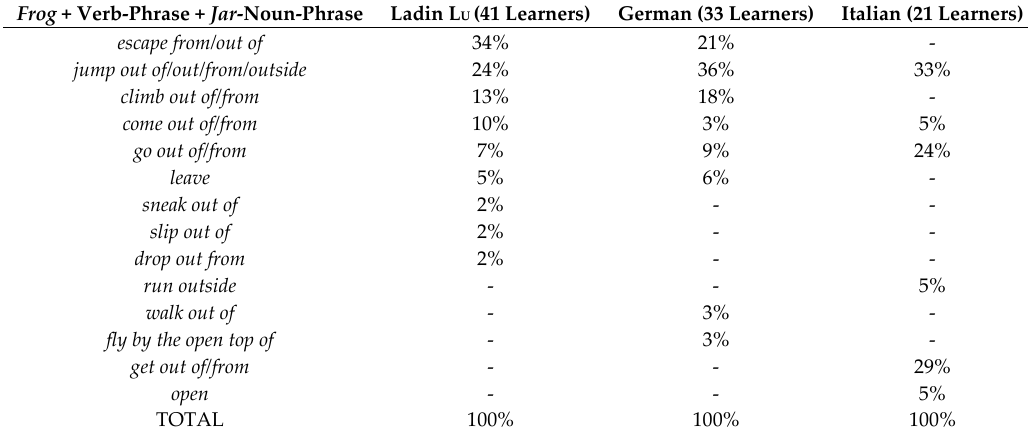
Table 4. Verb-phrases in the frog-leaves-jar scene, in the Ladin upper secondary school (L U ), German, and Italian groups.